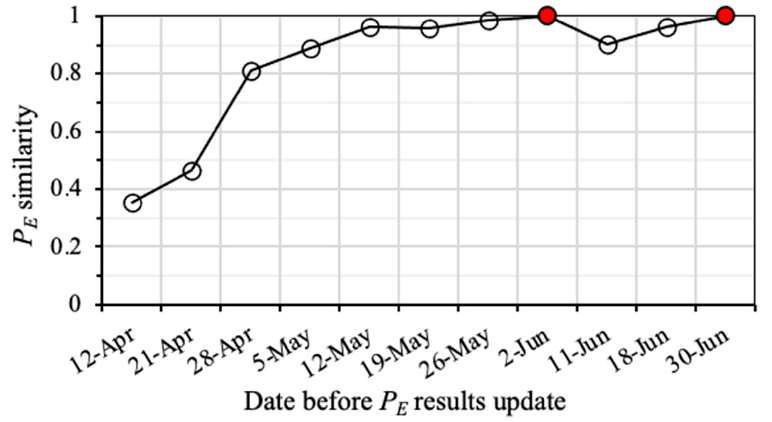
Figure 8. Similarity of weekly P E results for the seismic monitoring system to detect seismic events with logE = 4 in LW250105 during April to June 2014. Red dots are the last P E result before the layout modification of geophones.